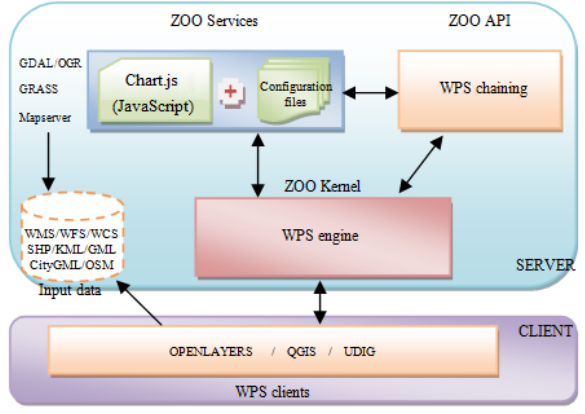
Figure 2. The Architecture of ZOO project for WebGIS platform including Chart.js as an example of aditional WPS (ZOO project,